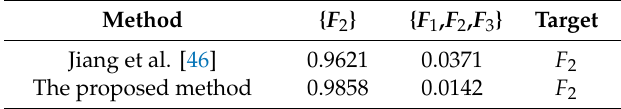
Table 6. Fusion results of di ff erent methods for motor rotor fault diagnosis at 2 X frequency.